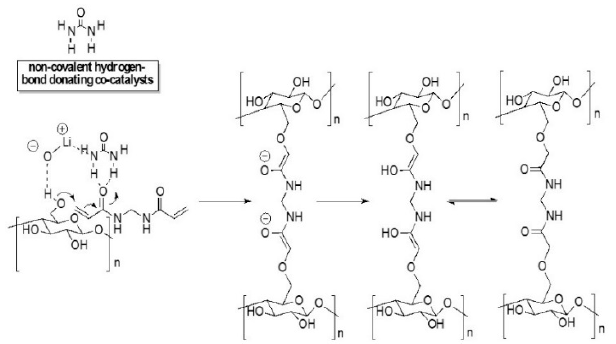
Figure 6. Hypothetical mechanism for hydrogel formation based on the Michael addition of cellulose to the α , β -unsaturated amide (MBA).